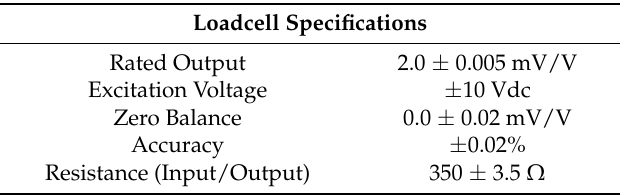
Figure 7. Installation for the EMB performance test rig: ( a ) system installation; ( b ) parts of caliper. Table 2. Loadcell specifications.